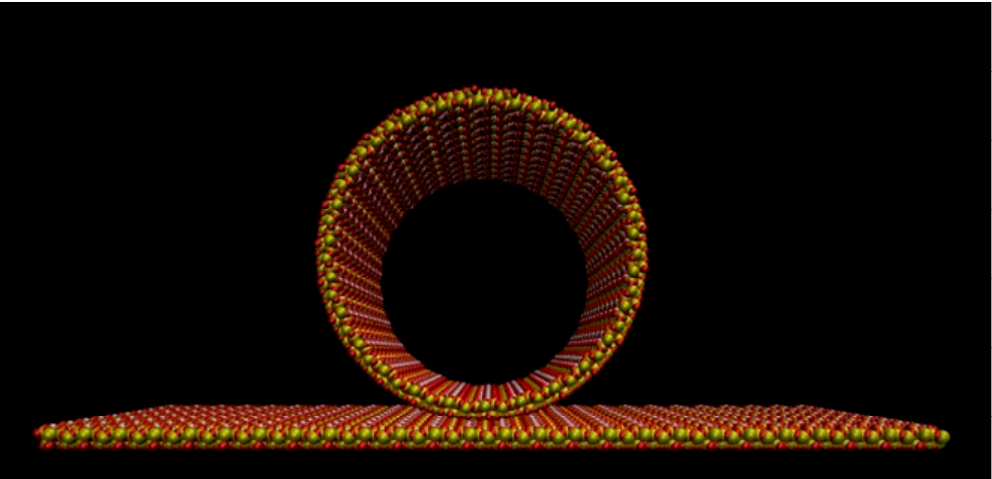
Figure 7. The rolling of the silica slab to form a cylindrical mesopore. The hydroxylated side of the slab becomes the inner surface of the pore. Atom colors: Si = yellow; O = red, H = white.